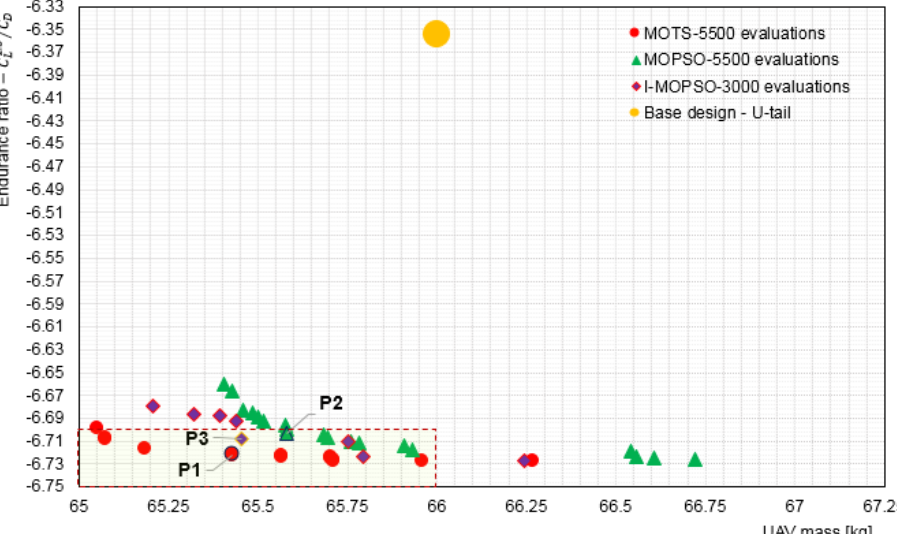
Figure 23. Pareto fronts for all runs and selected configurations compared with base design, it is evident that interactive optimisation provided very competitive results using only 3000 evaluations.